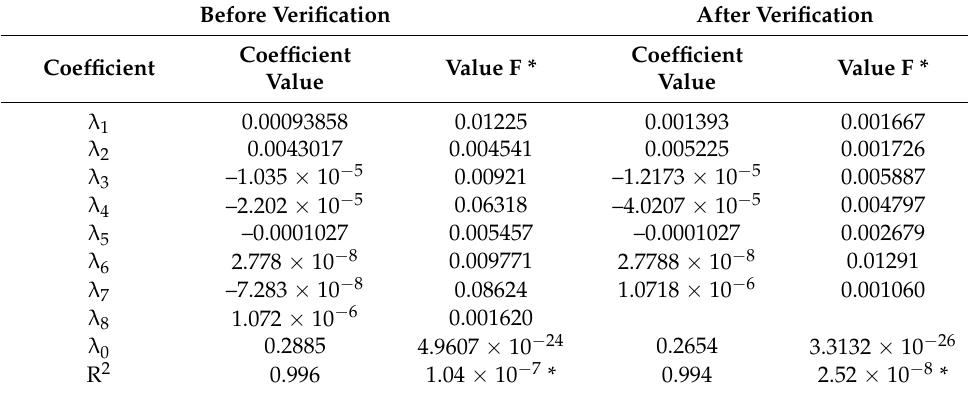
Table 2. Regression function coefficients with R 2 fitting for the µ m model.